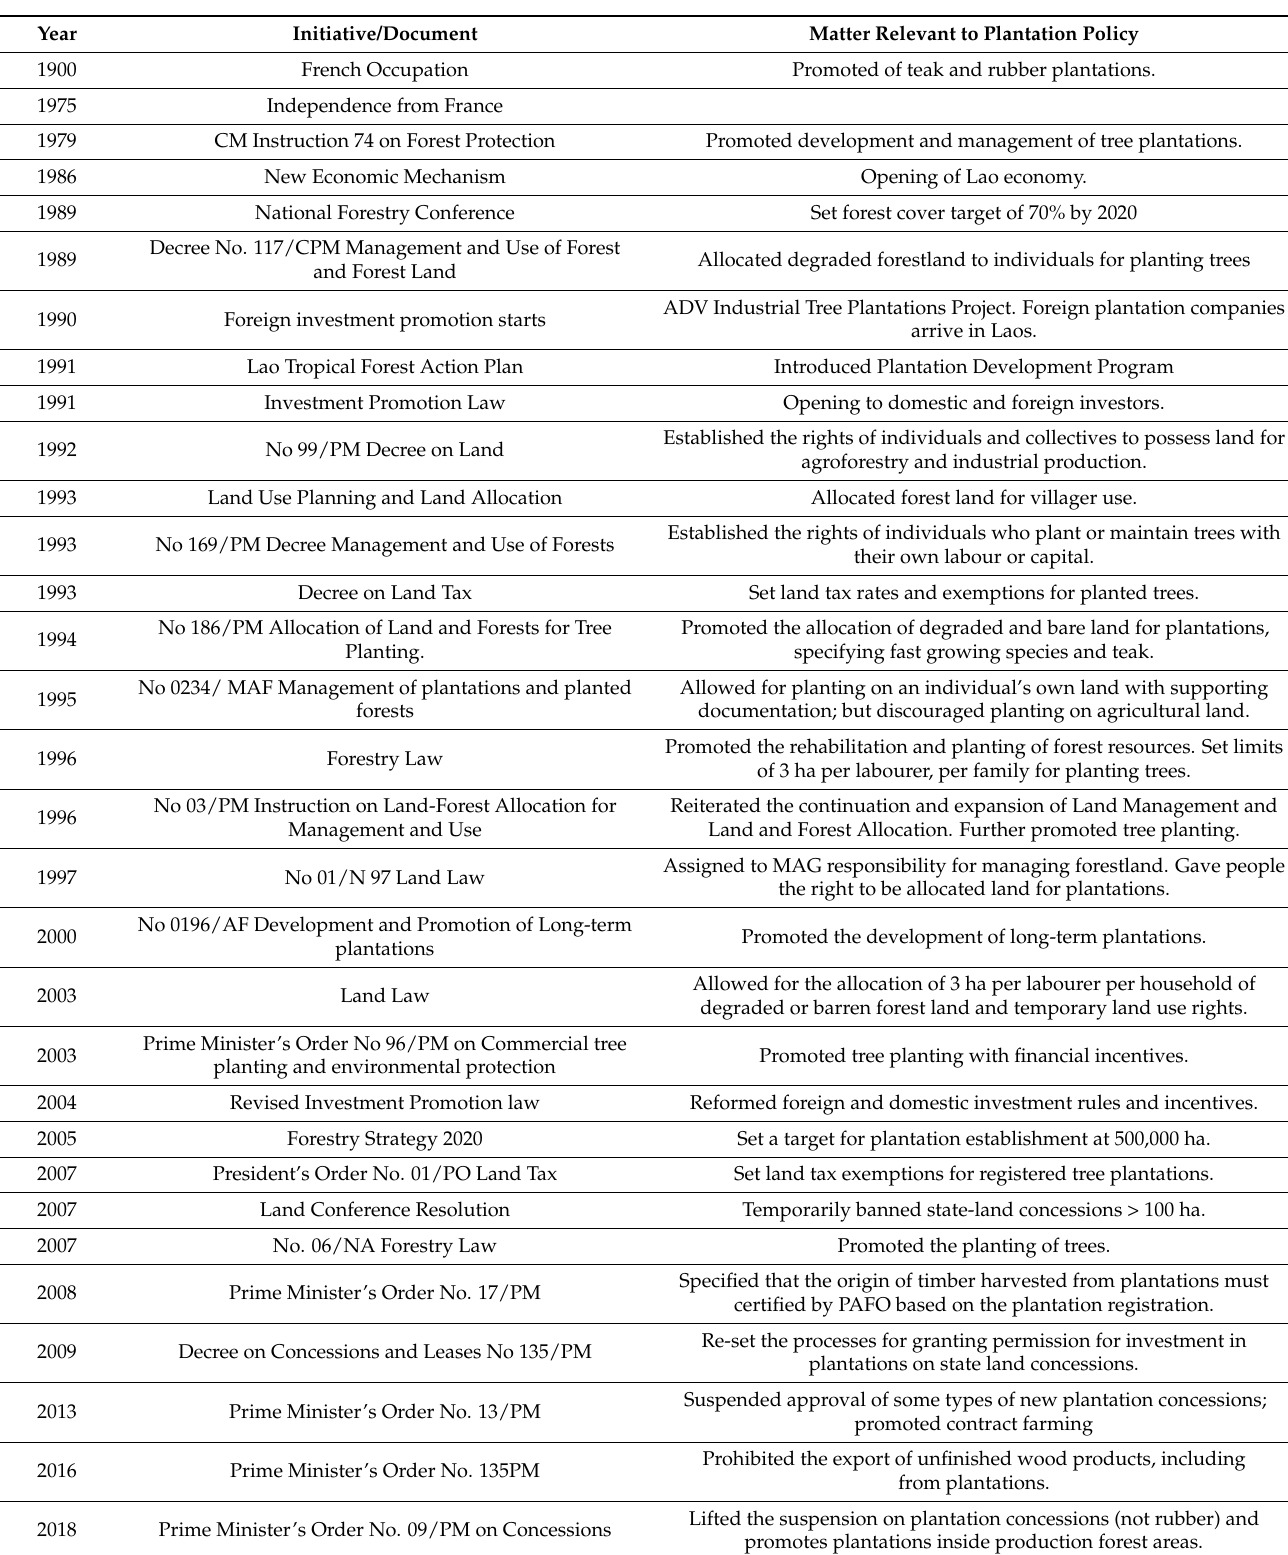
Table A1. Chronology of key forest-related policy initiatives or measures in